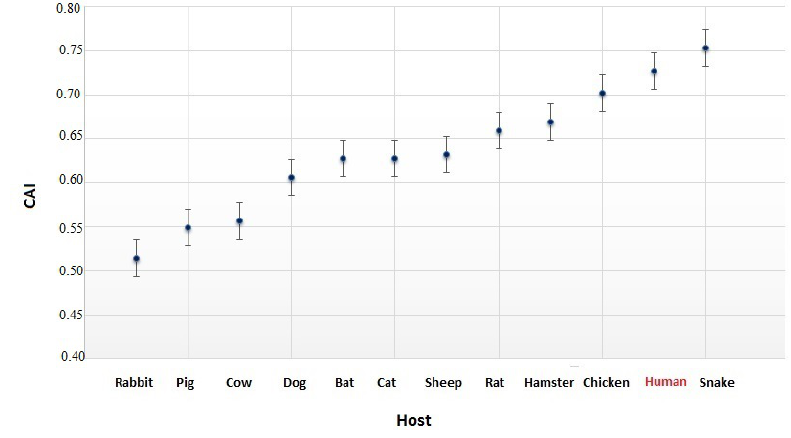
Figure 3. CAI values of SARS-CoV-2 for different hosts. On the horizontal axis, the 12 eukaryotic species are shown that were considered in the comparisons. The host species are ranked in ascending order. CAI values for snake and human hosts are higher than those for other